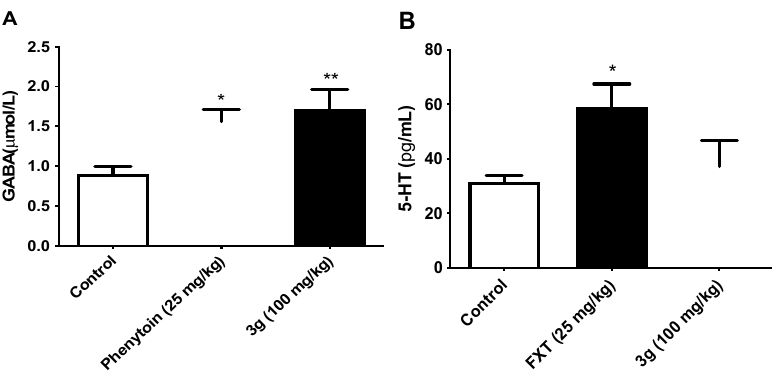
Figure 6. Effects of 3g , phenytoin, and FXT on whole brain GABA ( A ) and 5-HT ( B ) levels in mice brains. Eight animals were used for each group. * p < 0.05 compared to the control group, ** p < 0.01 compared to the control group.